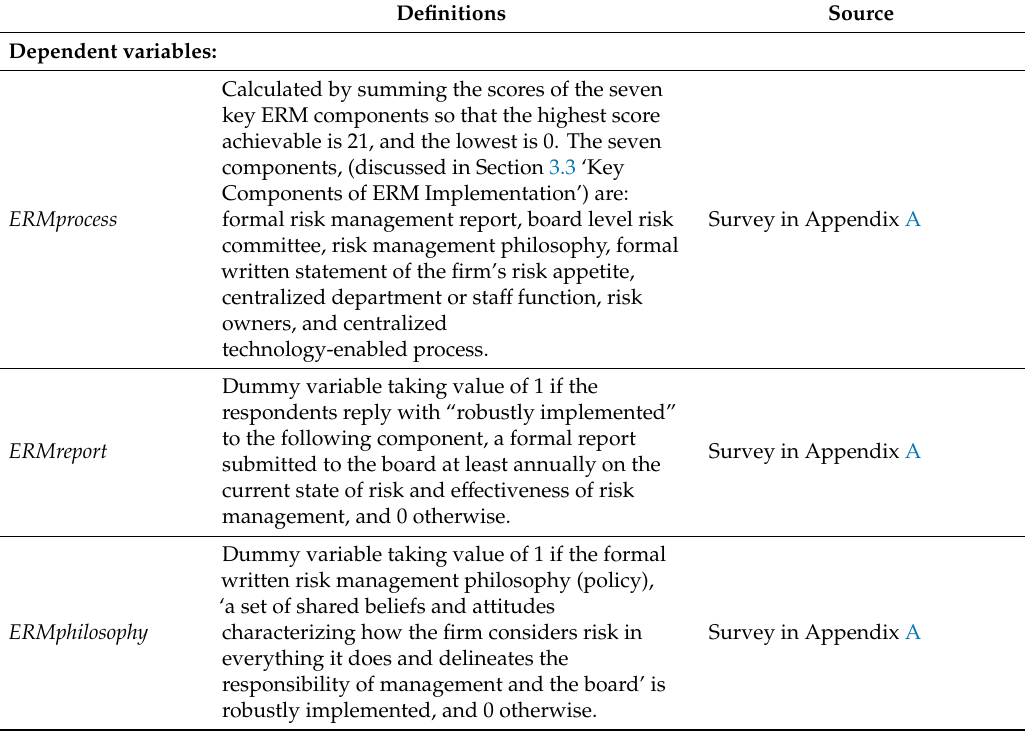
Table 1. Definition of